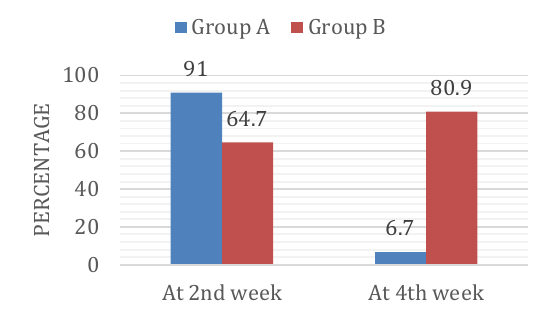
Figure 1: Response of Group A and Group B at 2 nd weeks and after cross over of drug at 4 th week The patients who were still having the symptoms after 4 week follow up